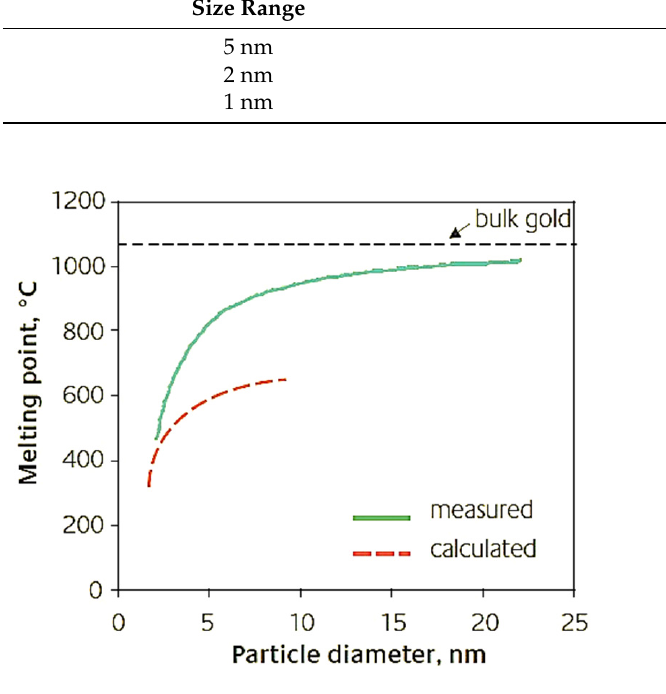
Table 1. Melting points of AuNPs for different nanoparticle size measured by Dick et al. [25] and Liu et al. [17,26].